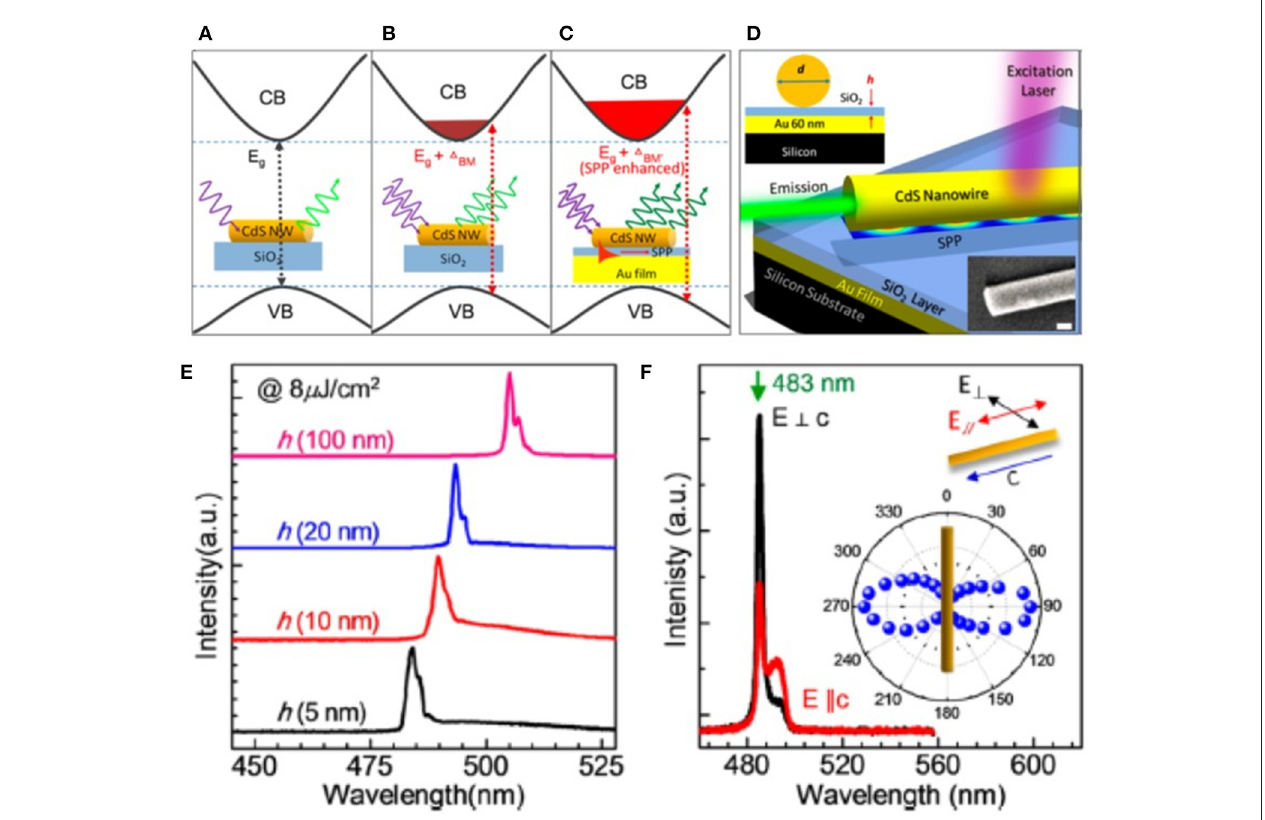
FIGURE 12 | An illustration of the various effects on the band gap energy of non-doped semiconductor nanowires: (A) without the BM effect (under low pump fluence), (B) with the BM effect (under high pump fluence), and (C) the SPP enhanced BM effect. (D) A schematic of the nanowire laser devices. Inset shows the SEM image of a single CdS nanowire on the gold film. Scale bar: 100nm. (E) The lasing peaks of four devices under the same pump fluence of 8 µ J cm − 2 . (F) Polarization-dependent lasing properties of the device. Inset is the far-field distribution of the lasing emission at ∼ 483nm. (A–F) Reproduced with permission. Liu X. et al. (2013) Copyright 2013, American Chemical